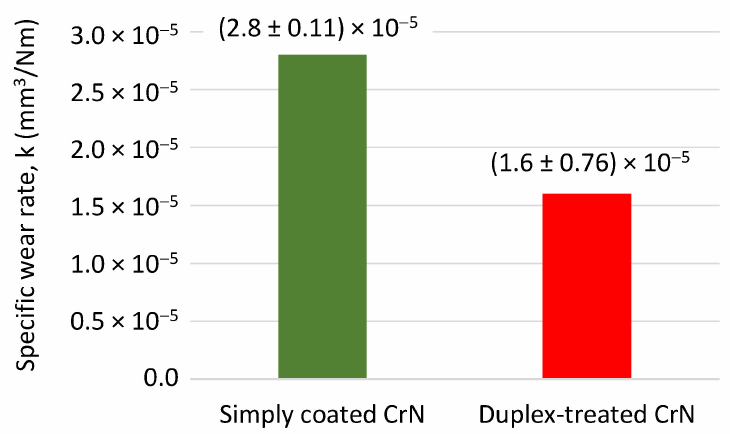
Figure 11. The specific wear rate for the simply and duplex-treated